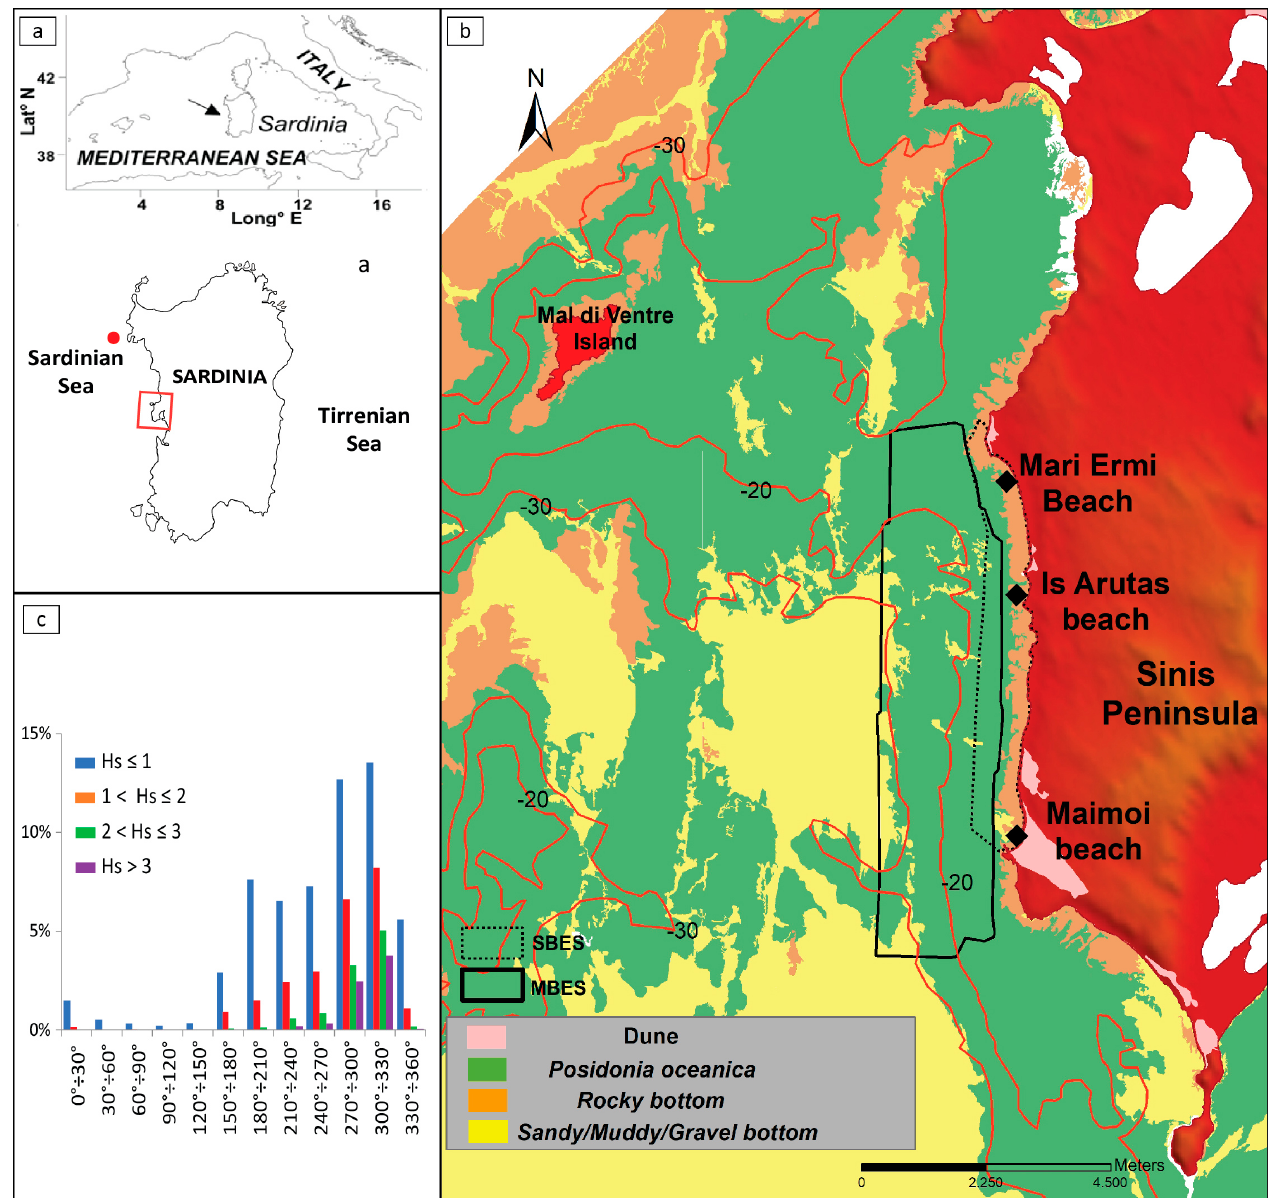
Figure 1. The study area as follows: ( a ) Sardinia Island and the position of the wave buoy (red dot); ( b ) Sinis Peninsula, the continuous black rectangle indicates the multibeam acquisition area, the dashed black rectangle indicates the single-beam acquisition area; and ( c ) yearly statistics of the wave height recorded by the wave buoy available at http://dati.isprambiente.it/dataset/ron-rete-ondametrica-nazionale/, accessed online 30 April 2021 .